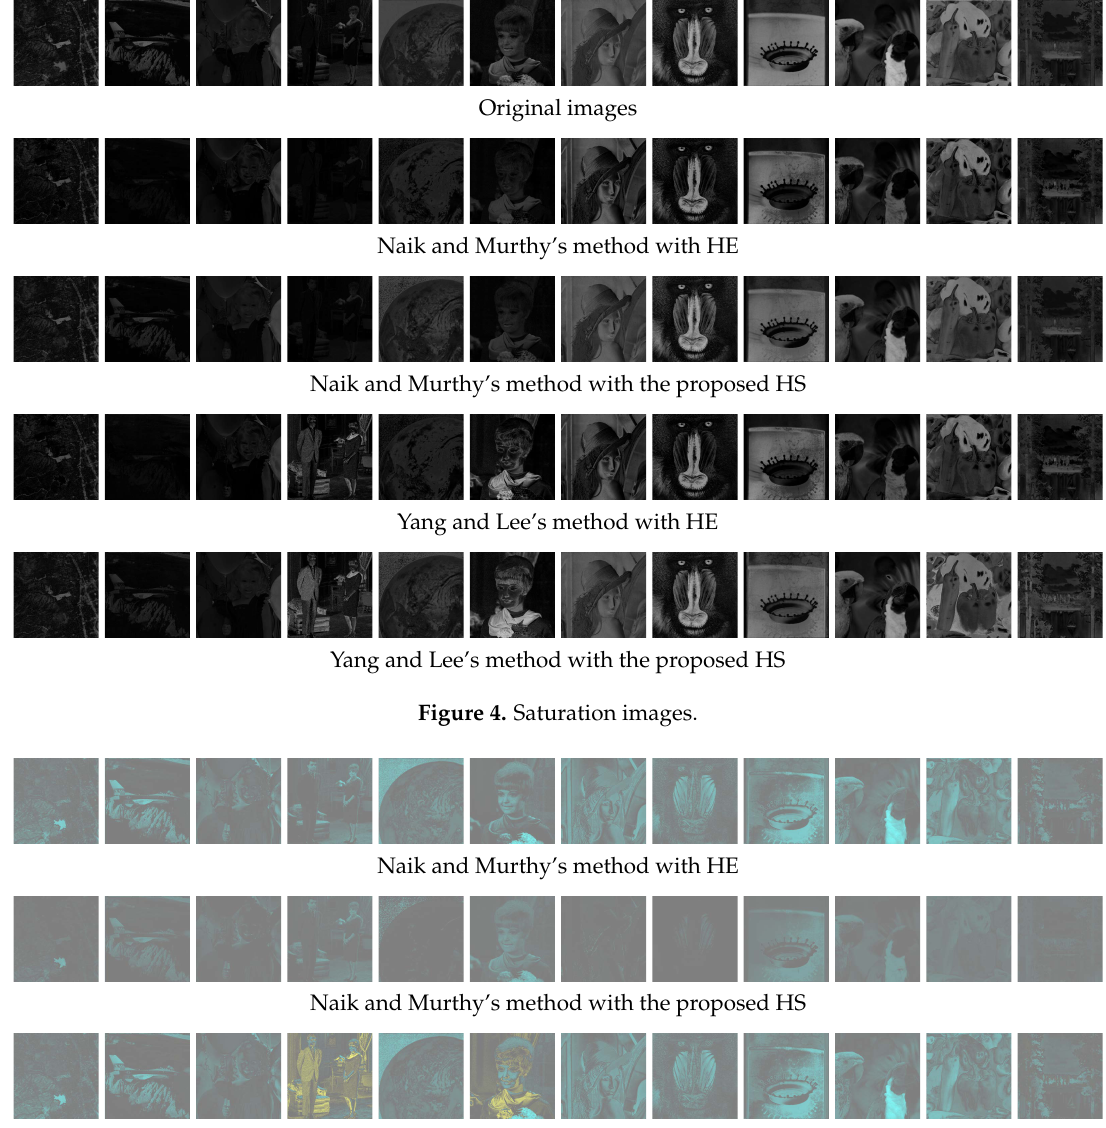
Figure 5. Difference maps of saturation